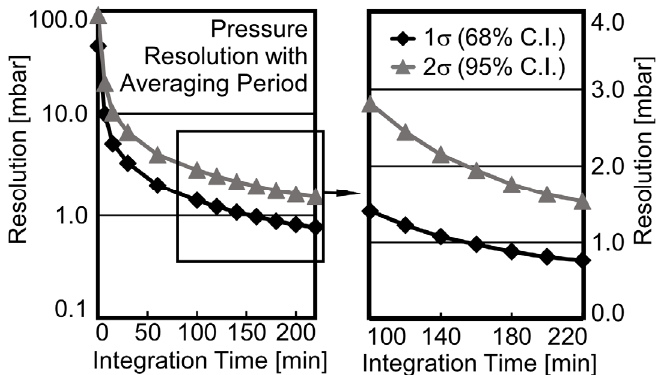
Figure 11. Measured pressure resolution ( Resol Meas ) of PGM system.